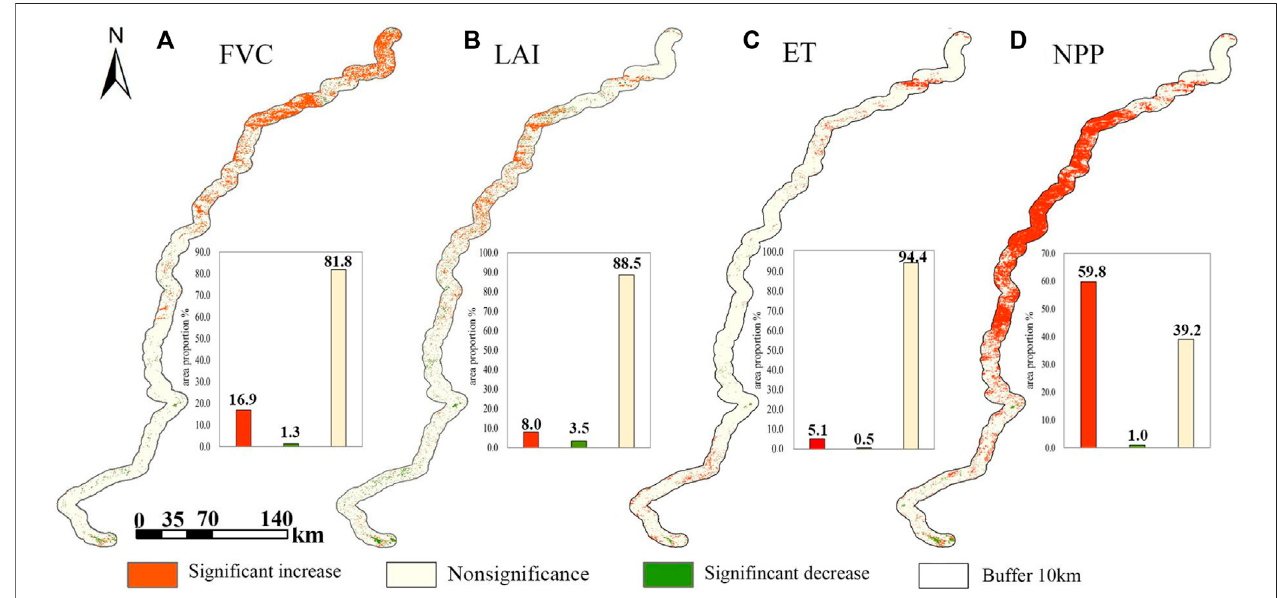
FIGURE 4 | Variation trends of ecosystem service indicators and signi fi cance tests in the study period. ( (A) FVC; (B) LAI; (C) ET; (D) NPP).